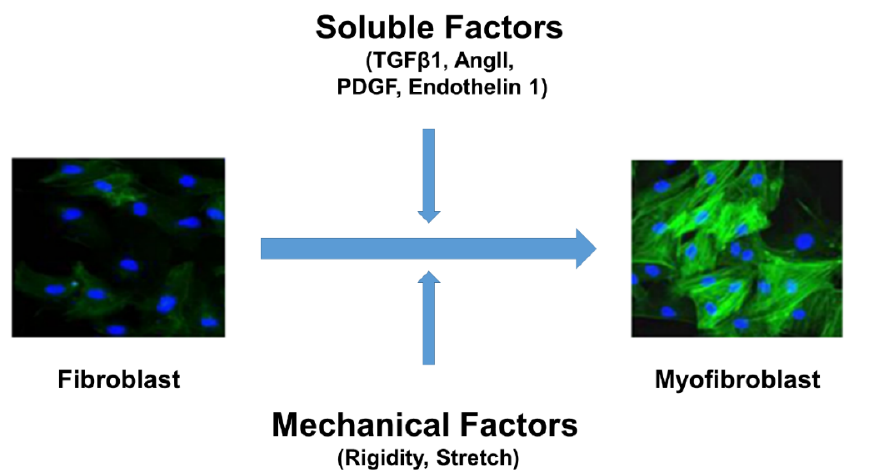
Figure 1. Fibroblast differentiation into myofibroblasts is a key event in fibrosis. Both soluble factors (TGF- β or Ang II or PDGF or Endothelin 1) and mechanical factors (stretch and stiffness) are required for cardiac fibroblasts differentiation into hyper-secretory and hyper-contractile phenotype myofibroblasts ( α -SMA (green) expression and incorporation into stress fibers are known markers of myofibroblasts; nuclei were stained in blue). Ang II = angiotensin II; α-SMA = α-smooth muscle actin; TGF-β = transforming growth factor β. PDGF = Platelet derived growth factor.